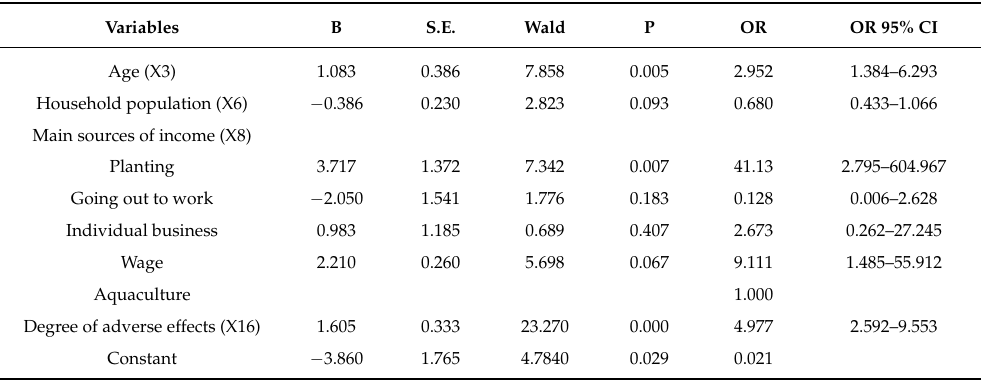
Table 5. Logistic regression results of